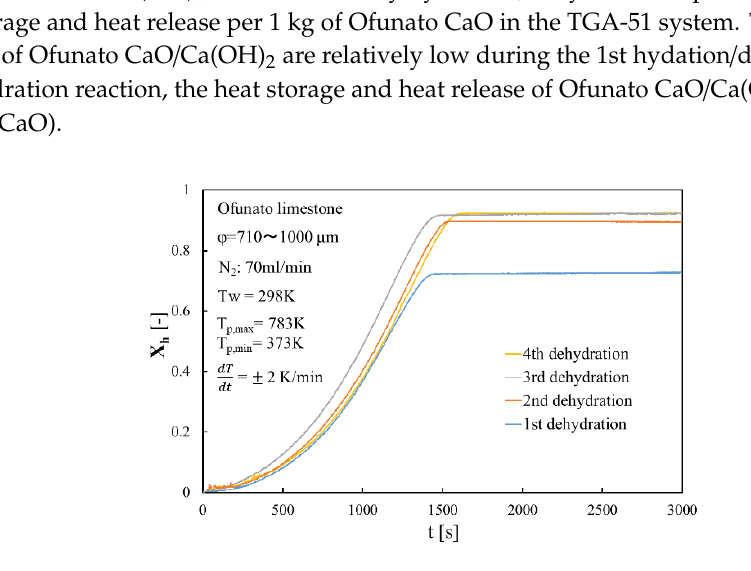
Figure 11. Dehydration conversion of Ofunato CaO in TGA-51 after decarbonization at 1223 K for 5 h. in muffle furnace.